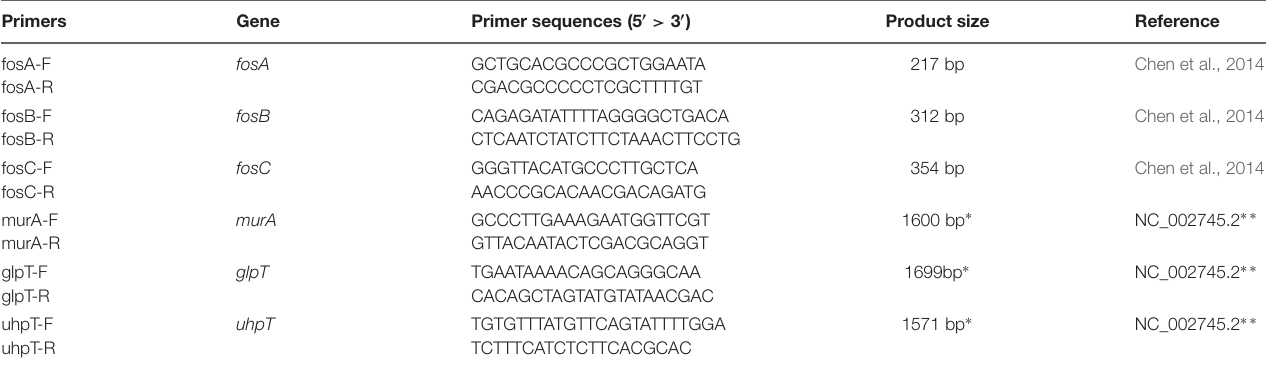
TABLE 1 | PCR primers of fosA , fosB , fosC , murA , glpT and uhpT gene.